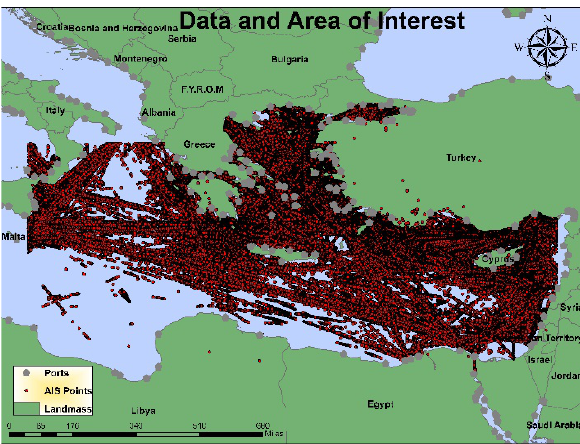
Figure 1. Data Area of